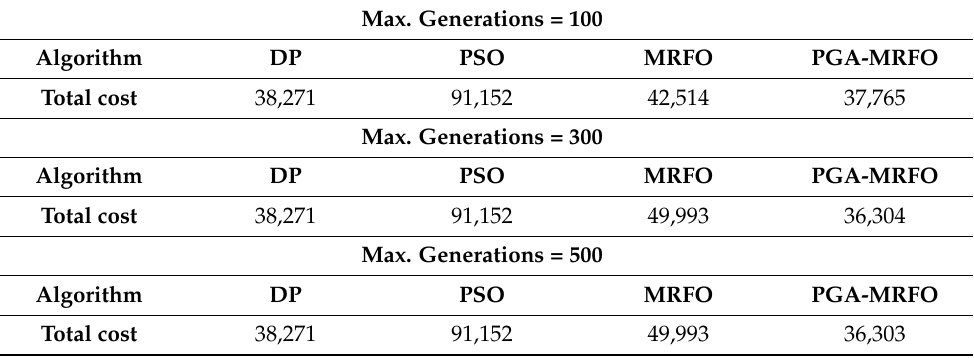
Table 6. Results of the four algorithms for the UC problem—Case 2 with a constant population size of